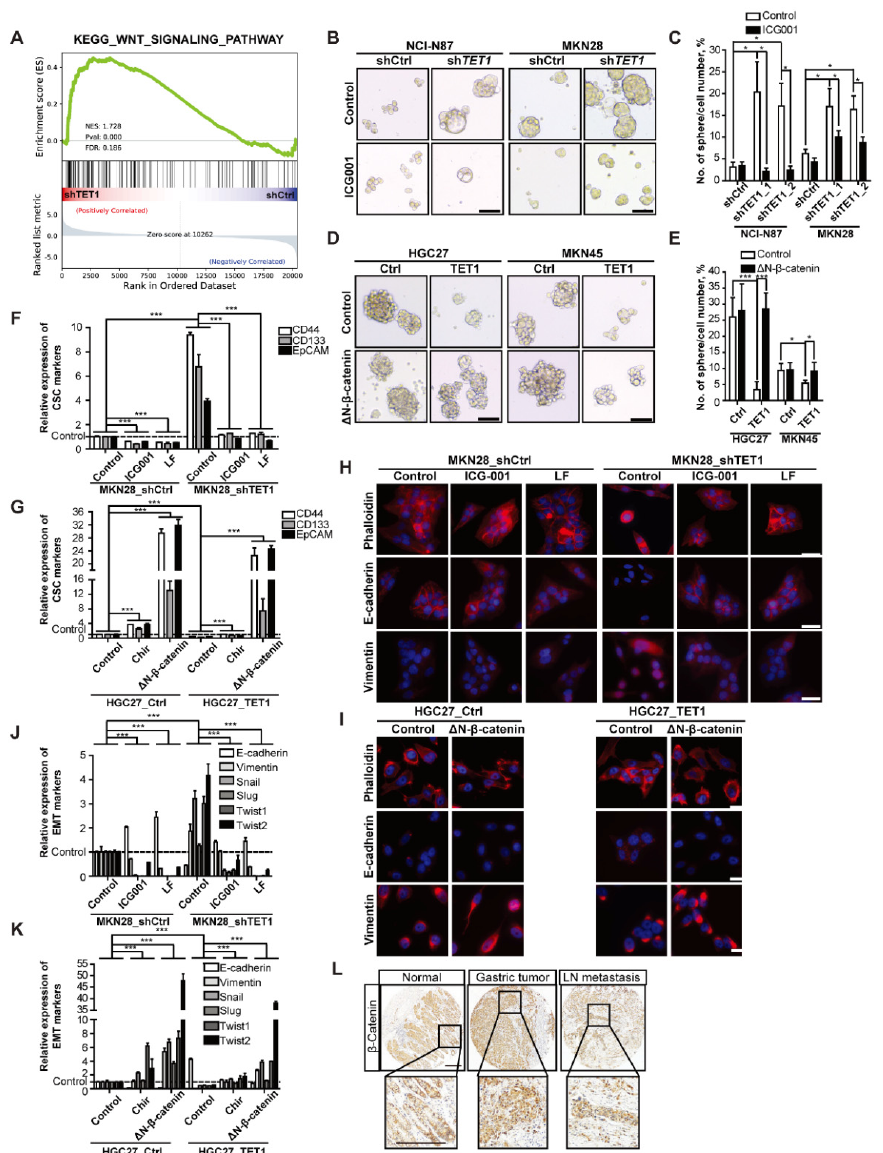
Figure 4. Inhibitory effects of TET1 on CSCs and EMT can be reversed by activating Wnt signaling. ( A ) GSEA analysis of RNA-seq data showing activation of WNT signaling pathway in AGS_shTET1 compared to shCtrl cells. ( B ) Representative pictures of spheres generated by stable NCI-N87 and MKN28 cell lines treated with 25 µmol/L ICG001 or DMSO solvent as control. Scale bars represent 100 µm. ( C ) Numbers of spheres per 100 cells treated as in ( B ). ( D ) Representative pictures of spheres generated by stable HGC27 and MKN45 cell lines transfected with constitutively active Δ N- β - catenin or empty vector as control. Scale bars represent 100 µm. ( E ) Numbers of spheres generated per 100 cells treated as in ( D ). ( F ) qRT-PCR analysis of the cancer stem cell markers in MKN28 stable cell lines treated with 25 µmol/L ICG001, 30 µmol/L LF or DMSO solvent as control. MKN28_shCtrl cells treated with DMSO solvent were used as control. ( G ) qRT-PCR analysis of the cancer stem cell markers in HGC27 stable cell lines treated with DMSO solvent as control, Chir, or transfected with Δ N- β -catenin. HGC27_Ctrl cells treated with DMSO solvent were used as control. ( H ) IF staining of